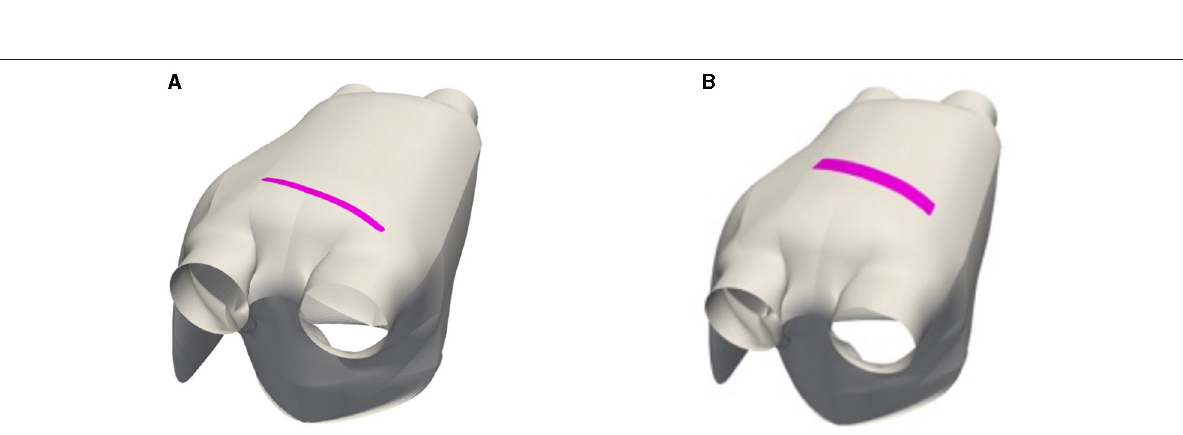
Frontiers in Physiology |